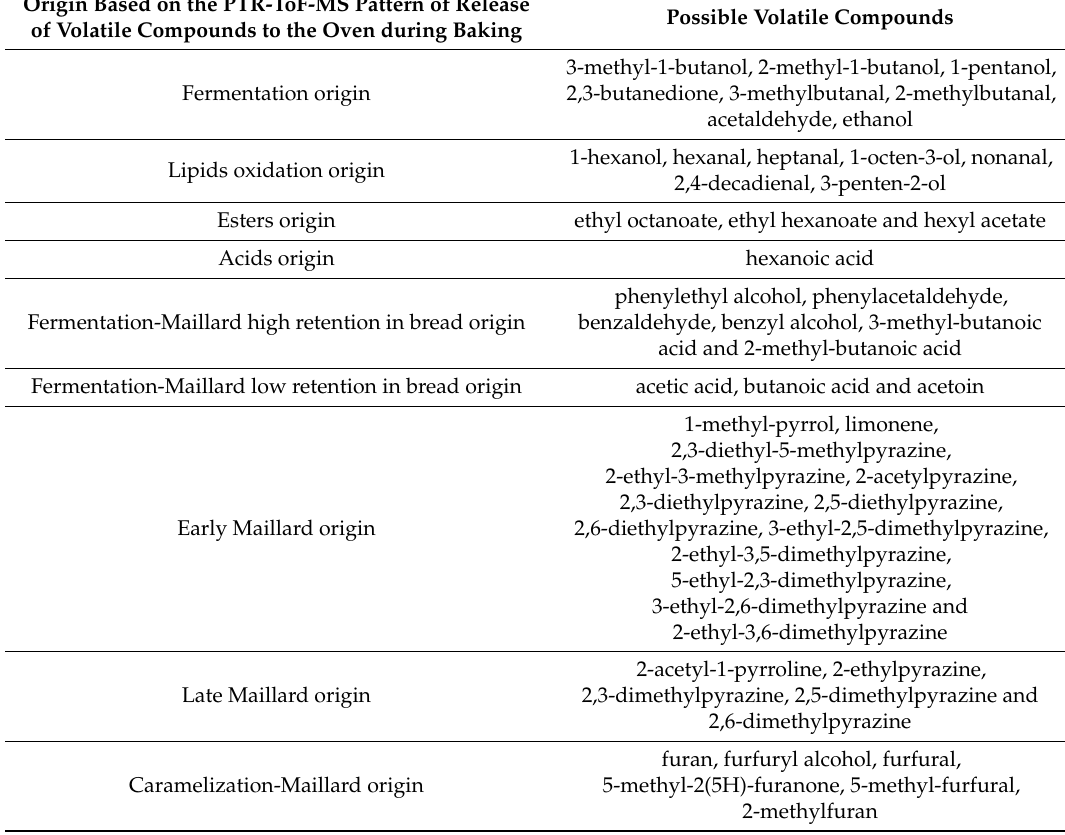
Table 2. Di ff erent patterns found among several gluten-free breads (quinoa, te ff , rice and wheat flours and corn and wheat starches) and wheat control bread in the release of volatile compounds to the oven (headspace) measured by PTR-ToF-MS during 40 min. of baking at 200 ◦ C. Origin Based on the PTR-ToF-MS Pattern of Release of Volatile Compounds to the Oven during